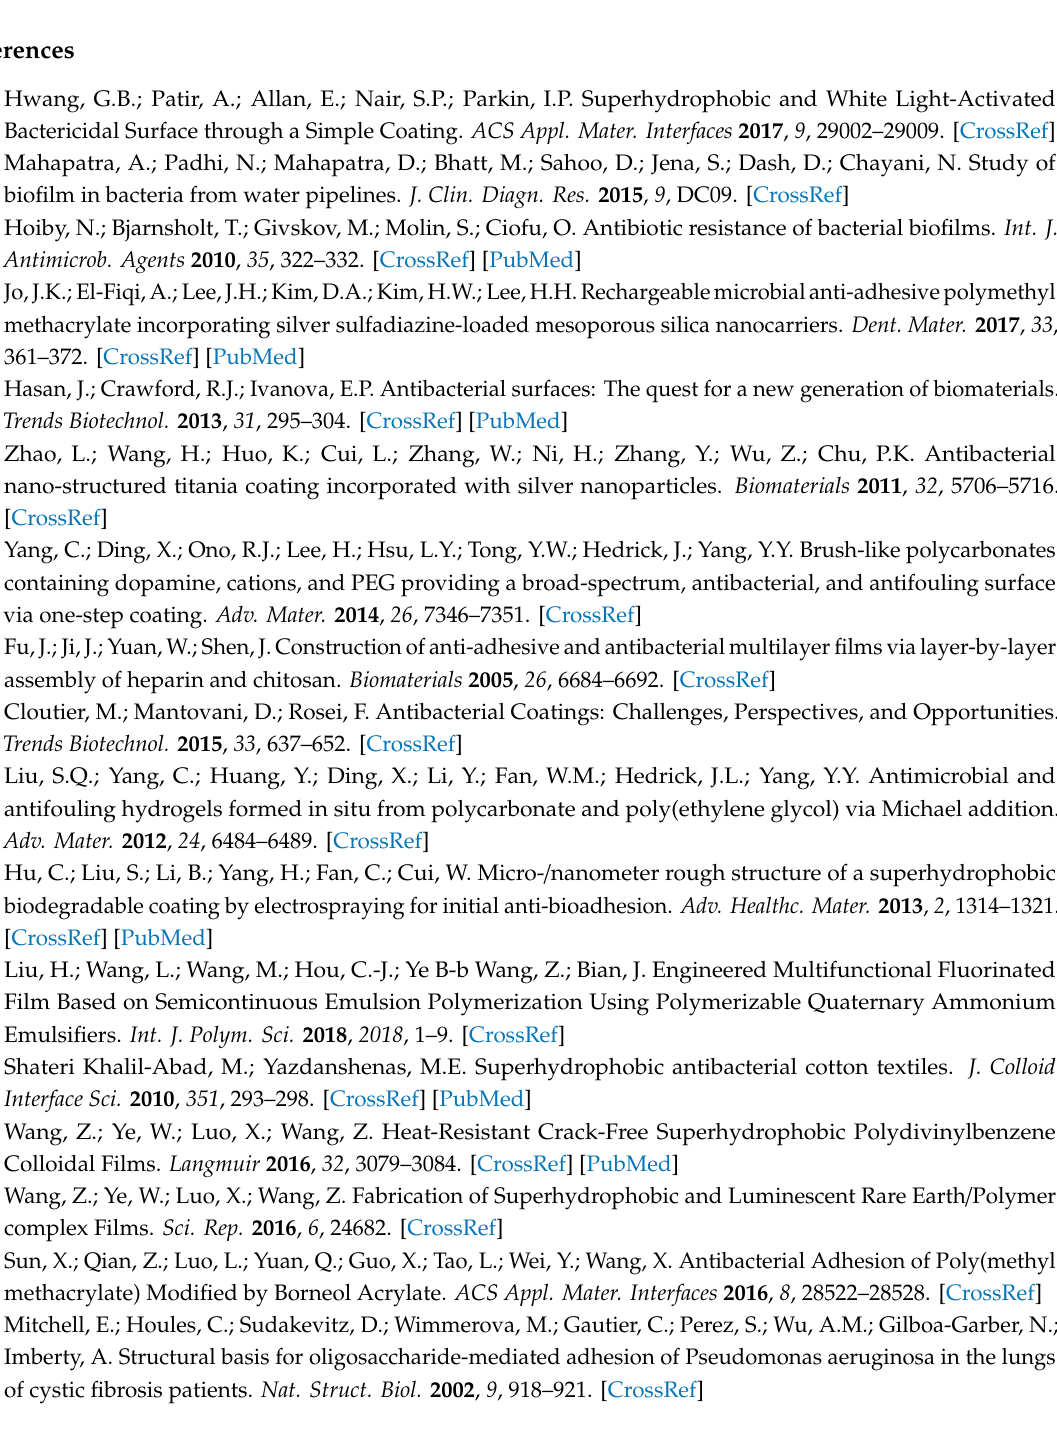
Figure S1: The 1 H NMR spectra of the